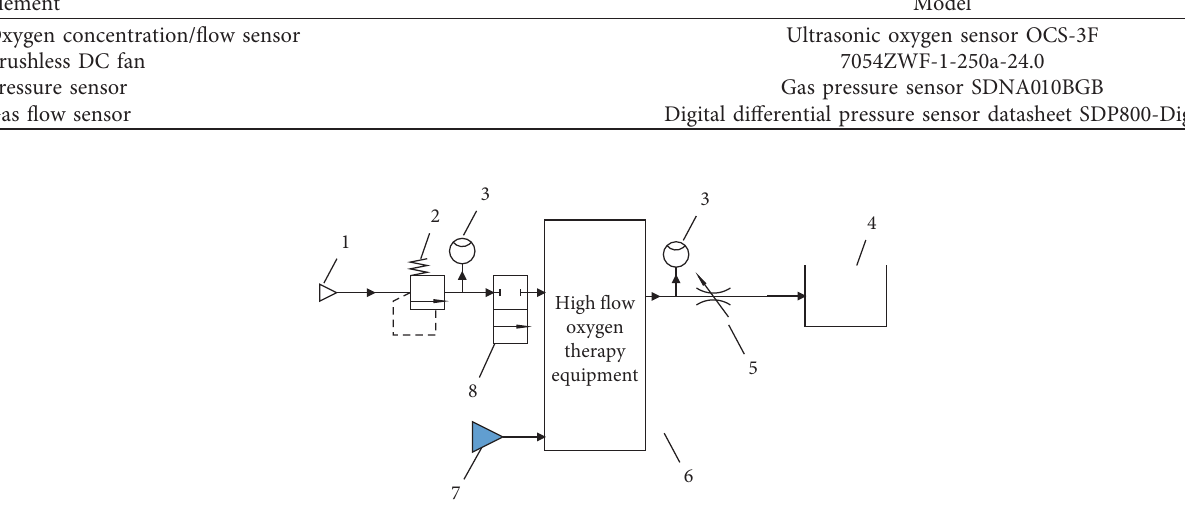
Figure 2: Physical experimental circuit of oxygen therapy machine. 1. High pressure oxygen source; 2. Pneumatic proportional pressure valve; 3. Flow sensor; 4. Container; 5. Throttle valve; 6. High flow oxygen therapy equipment; 7. Normal pressure air source; 8. Pneumatic on-off valve.